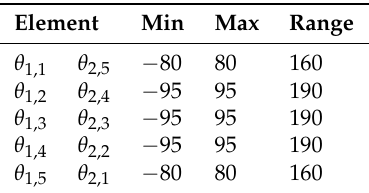
Table 1. Angular range of the WBRD.